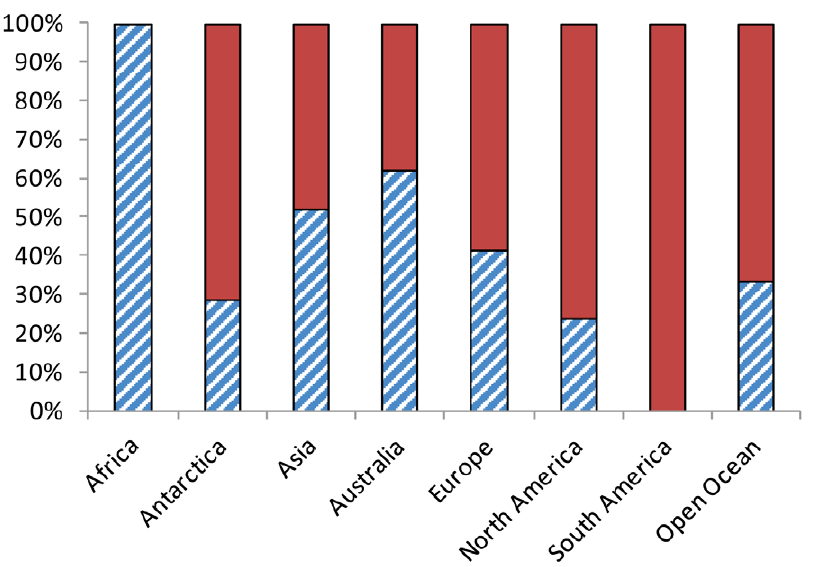
Figure 5. Proportion of species of Gymnodinium oncers described from each region. The proportion of oncers originally described from each region is given in blue stripes.